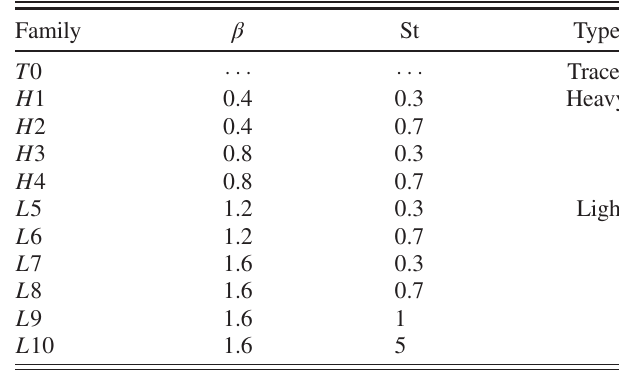
TABLE II. Lagrangian dynamics parameters. β ¼ 3 ρ f = ð ρ f þ 2 ρ p Þ , ratio of the fluid and the particle densities; St ¼ τ p = τ η , Stokes number. We evolve ten different families of inertial particles, plus a family of tracers. An ensemble of N 5 × 10 5 particles for each family is injected on 128 a ¼ different rotation axis, located in different positions inside the simulation volume. Additionally, a set of N r ¼ 4 × 10 6 particles per family is uniformly injected in the flow, in order to optimize the statistical sampling of the whole simulation